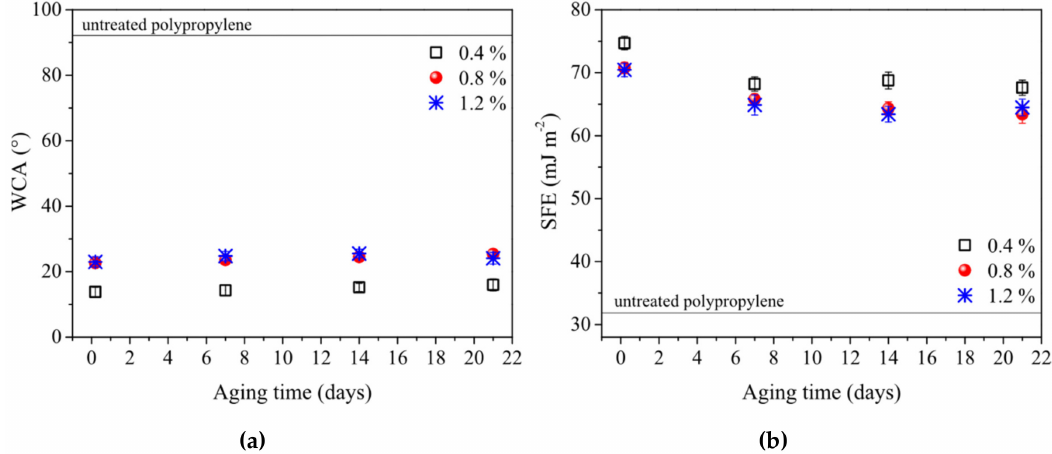
Figure 5. Changes of values ( a ) WCA and ( b ) SFE due to aging e ff ect. Values for three di ff erent compositions of processing gas, i.e., 0.4, 0.8, and 1.2% of P-B in nitrogen, are shown. A treatment time of 4 seconds was kept in all